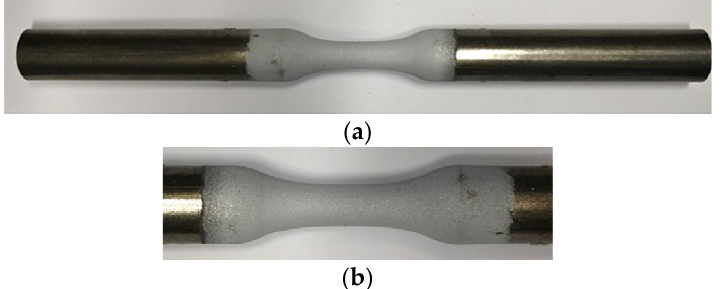
Figure 3. Macro images of ZnAl-coated (II) specimen, ( a ) overview, ( b ) detail of gauge length.